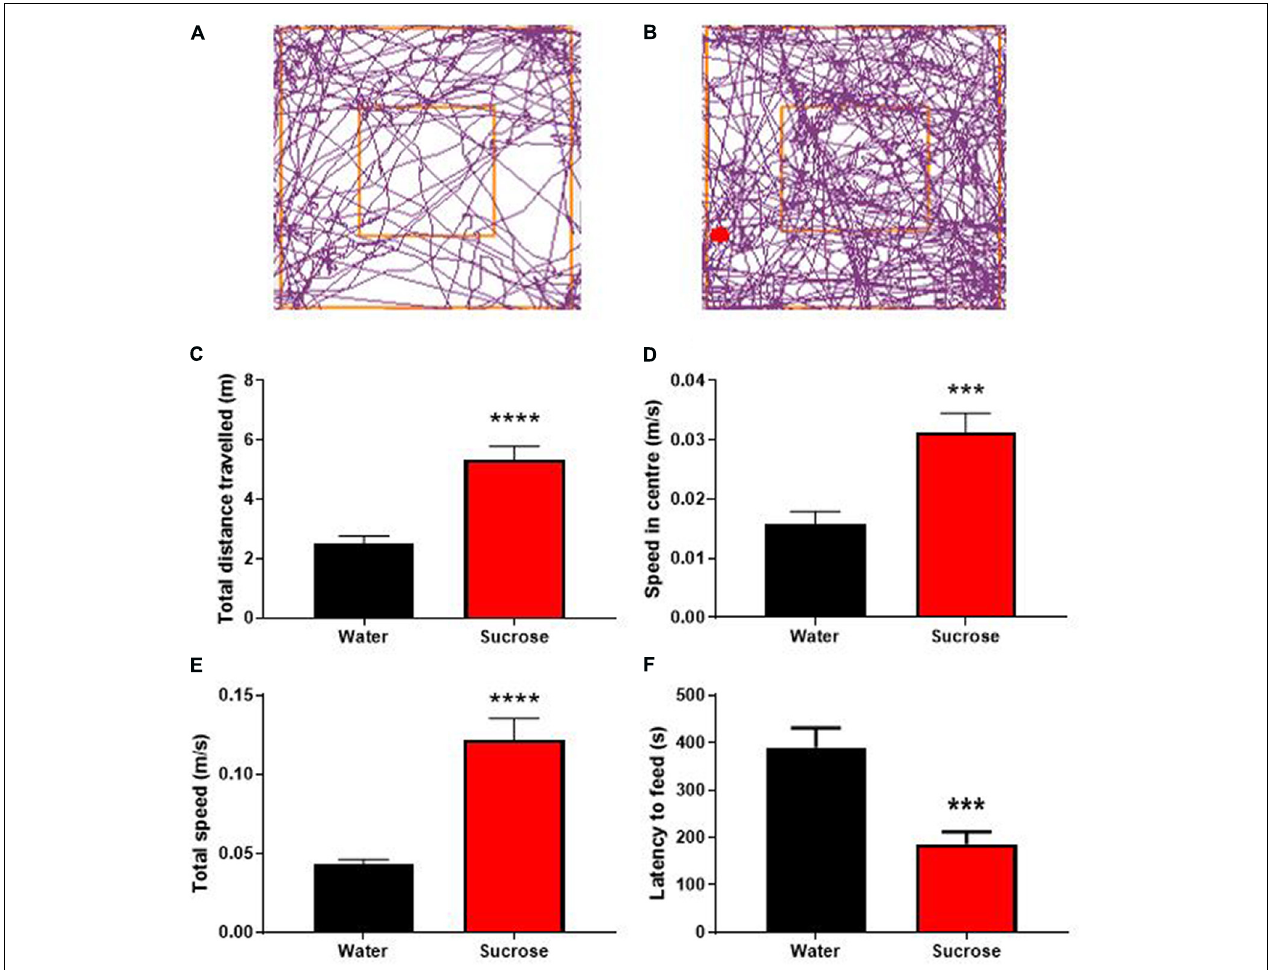
FIGURE 2 | Long-term sucrose consumption produces hyperactivity and reduces the control to resist food. Tracking plot of water- (A) and sucrose-consuming mice (B) illustrating that long-term sucrose consumption increases the total distances traveled in the open field (C) , the speed in the center (D) and total speed (E) in the open-field compared to water controls. Long-term sucrose consumption also reduced the latency to feed suggesting reduced control to resist food (F) . Data are presented as mean ± SEM; n = 8 mice/group. *** p < 0.001, **** p <